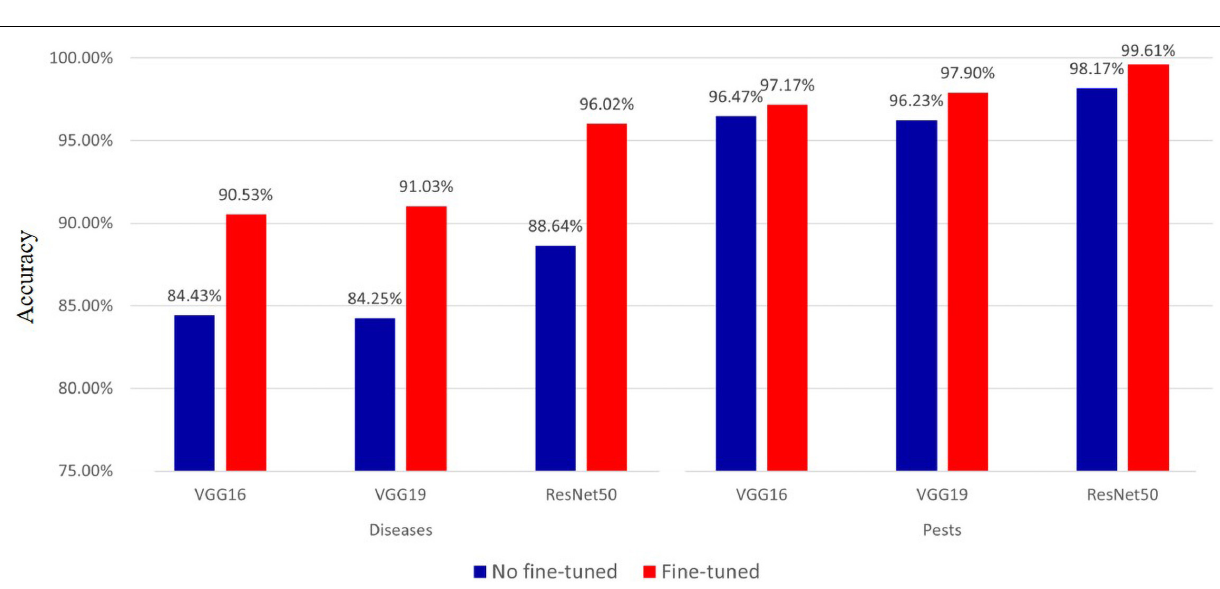
FIGURE 8 | Accuracy comparison of fine-tuned and non fine-tuned models in hot pepper diseases and